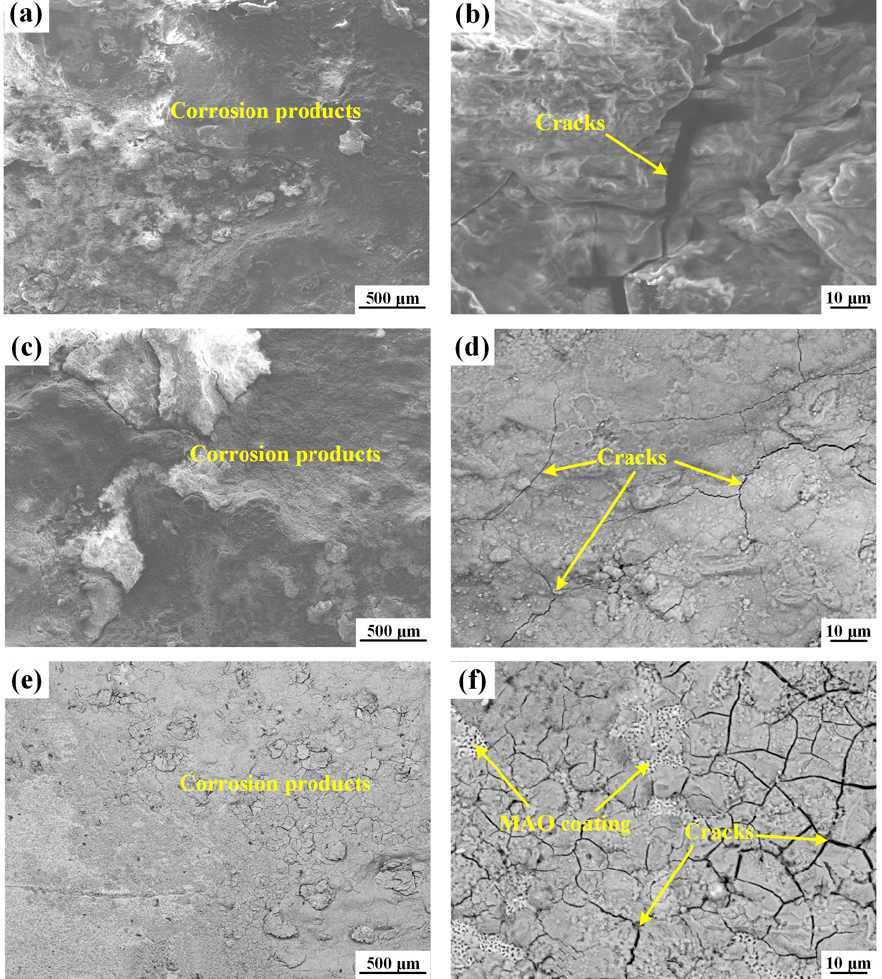
Figure 15. The SEM images of the surfaces of ( a , b ) ZK60E, ( c , d ) ZK60EF-300, and ( e , f ) MAO-coated ZK60EF-300 tensile specimens tested in 3.5 wt.% NaCl solution under 80 MPa.